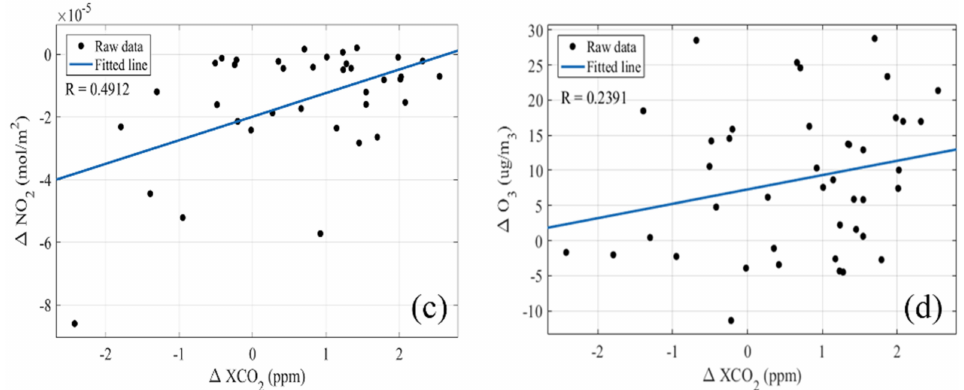
Figure 9. Relationship between the monthly averaged variation of XCO 2 observed by satellite and the monthly averaged concentration of NO 2 and O 3 observed by satellite ( c , d ) and ground monitoring stations observations ( a , b ) in February 2020 relative to 2019, respectively. Restricted by the matching of ground monitoring stations data and GOSAT_FTS_L3_V2.95 data, we retained part of GOSAT_FTS_L3_V2.95 point